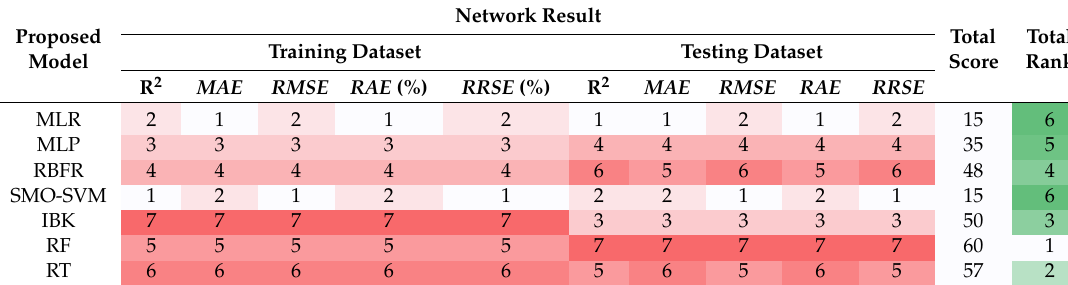
Table 5. Total ranking of both training and testing datasets in predicting the factor of safety. Network Result Proposed RankTraining Dataset Testing Model